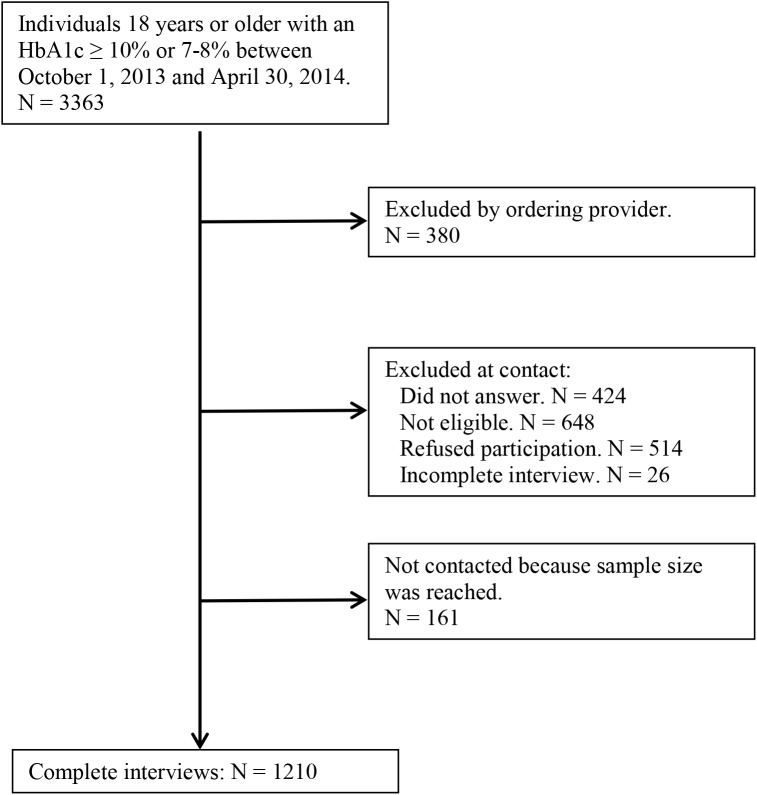
Details of participant selection.